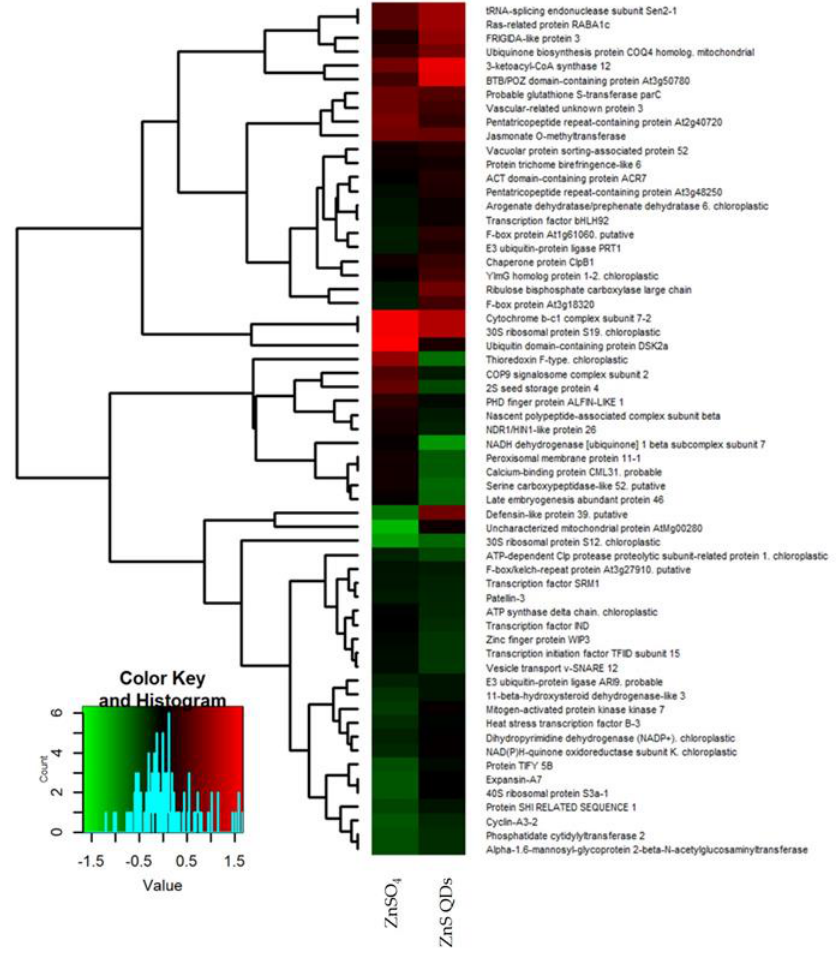
Figure 3. Heat map of proteins of N. caerulescens identified after separation by 2D SDS-PAGE and obtained through the “R” software. The columns represent two different treatments, while the rows represent the identified proteins. The shade of red indicates high abundance of proteins and the shade of green indicates low abundance of proteins in the treated samples as compared to the control which therefore is not shown here. In particular, the first column represents the abundance of proteins in the treated samples with ZnSO 4 and the second column represents the abundance of proteins in the treated samples with ZnS QDs. The heat map was assembled by cluster analysis therefore similar levels of expression in treatments as compared to the control are positioned at short distance, while different levels of expression in treatments as compared to the control are positioned at long distance. The more abundant proteins in treated samples compared to the control are posi- tioned at the top, the less abundant proteins are positioned at the bottom. Proteins that have an opposite behavior in the treated samples and in the control are positioned in the center of the figure.